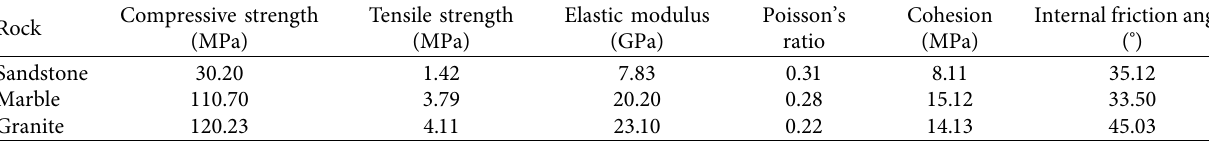
Table 1: Conventional mechanical parameters of the rock mass.